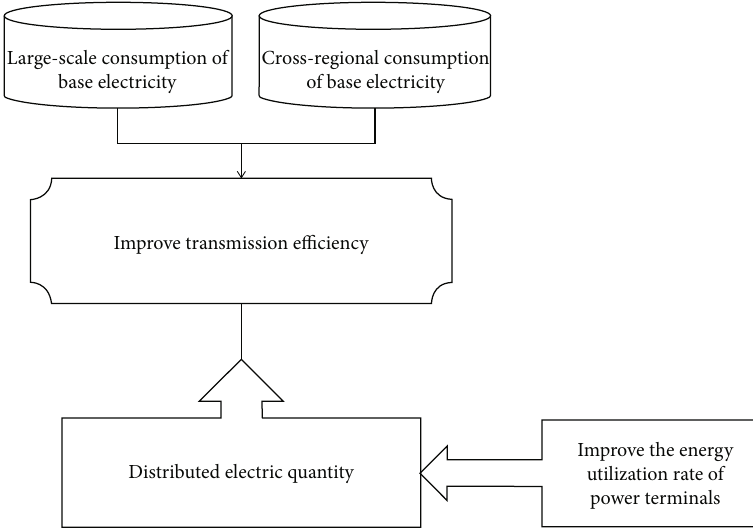
Figure 2: Energy-saving realization of electric